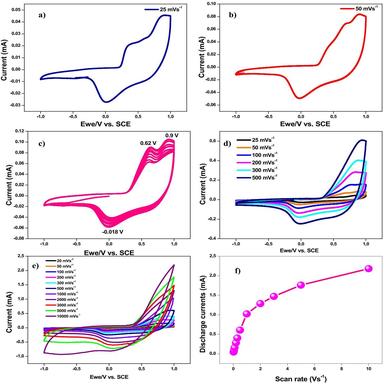
Cyclic voltammograms obtained at a) 25 mVs-1, b) 50 mVs-1, c) 100 mVs-1 (8 cycles), d) overlay of CVs at different scan rates from 25 to 500 mVs-1, e) 20 to 10,000 mVs-1 within the potential window – 1.0 to +1.0 V f) discharge currents as a function of scan rate.